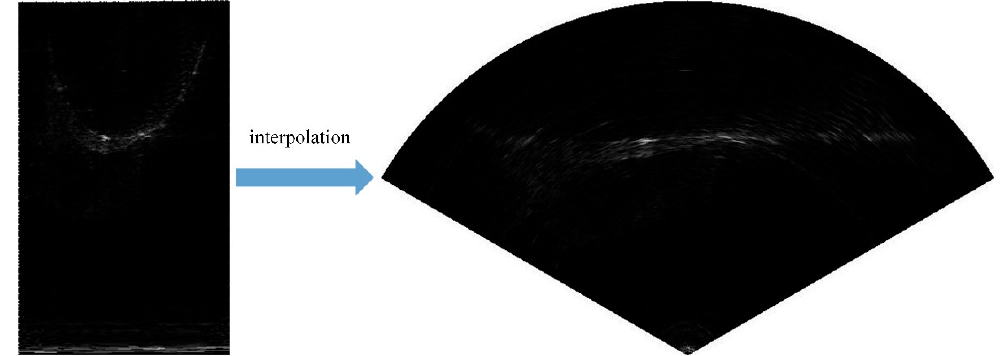
Figure 10. The comparison between image before interpolation ( left ) and image after